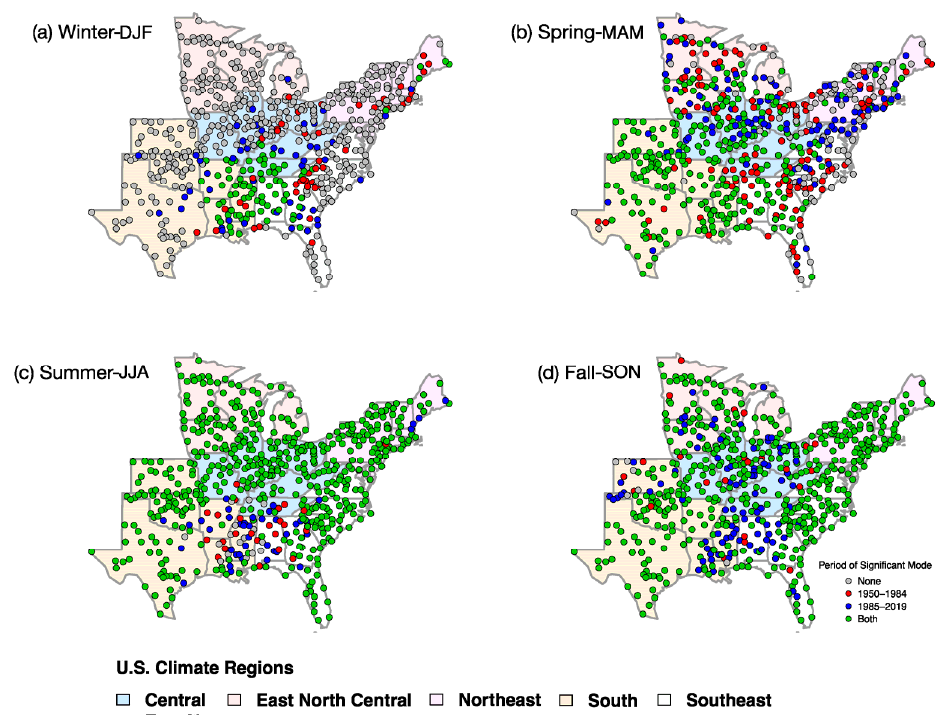
Figure 8. Seasonal distribution (modality) of AMP timing at a local scale based on the calendar dates of two 35-year blocks (1950–1984 and 1985–2019) of annual maximum daily precipitation. The season is considered as a significant mode when the number of significant days is at least twenty days per season.